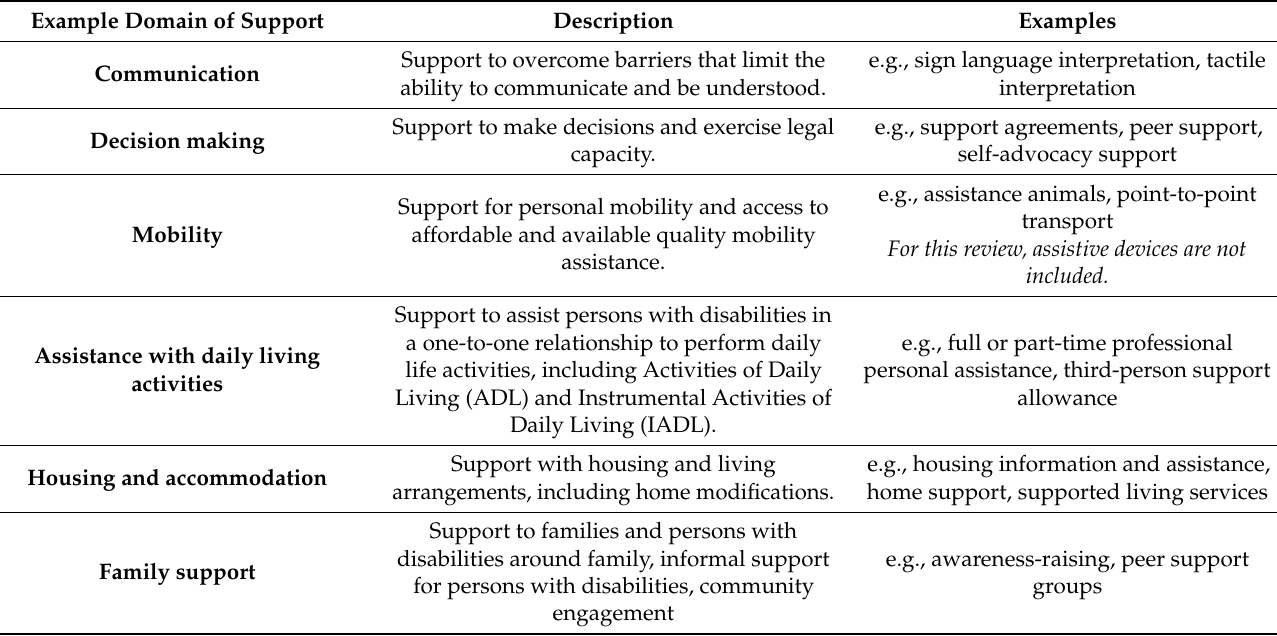
Table credit: Reprinted/adapted from V á squez Encalada, A.; Gupta, S.; Cote, A.; Tanhchareun, T.; Ghanem, A.; Pereira, M. A. (2021). The Disability Support Gap: Community support for persons with disabilities in low- and middle-income countries. Discussion paper. Centre for Inclusive